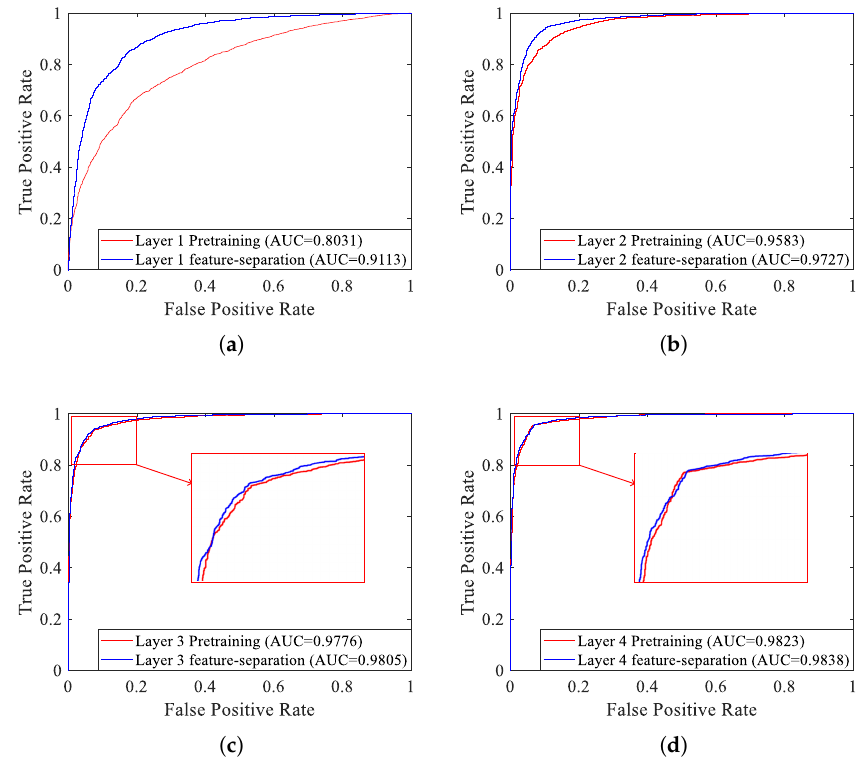
Figure 18. ROC curves of each layer under unsupervised pre-training and after fine-tuning with the supervised separation algorithm. ( a ) Layer 1. ( b ) Layer 2. ( c ) Layer 3. ( d ) Layer